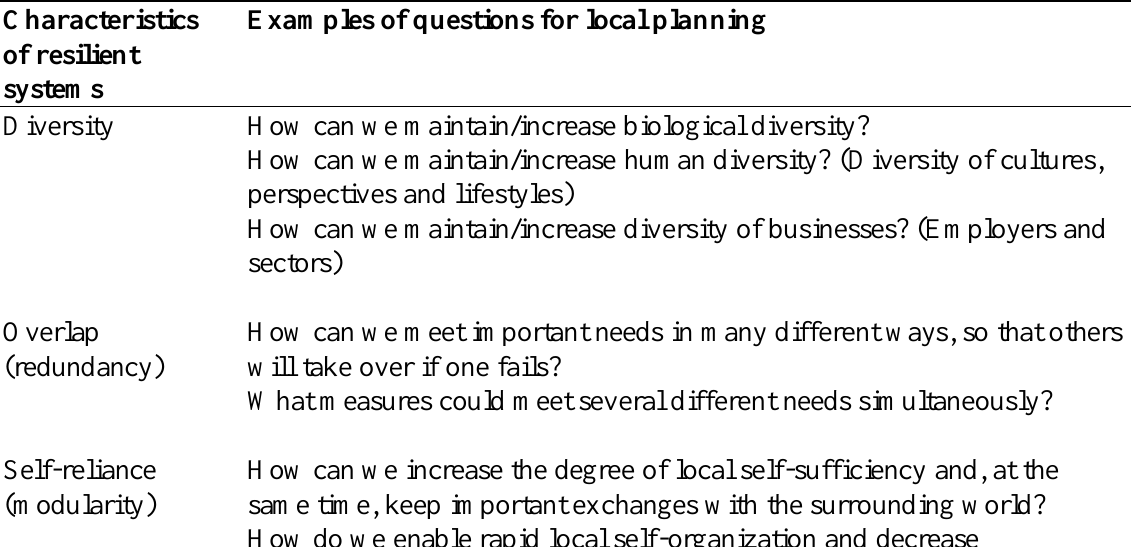
Table A3.1. Characteristics of a resilient system